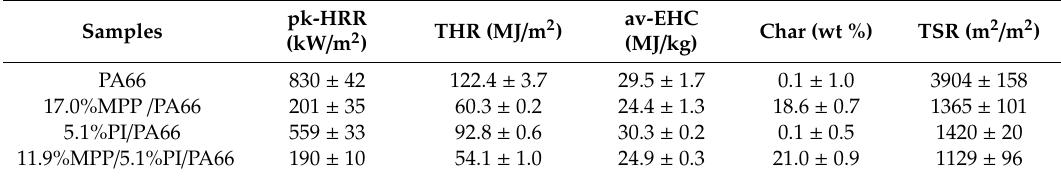
Table 3. Cone calorimeter data of the flame-retardant PA66 composites.